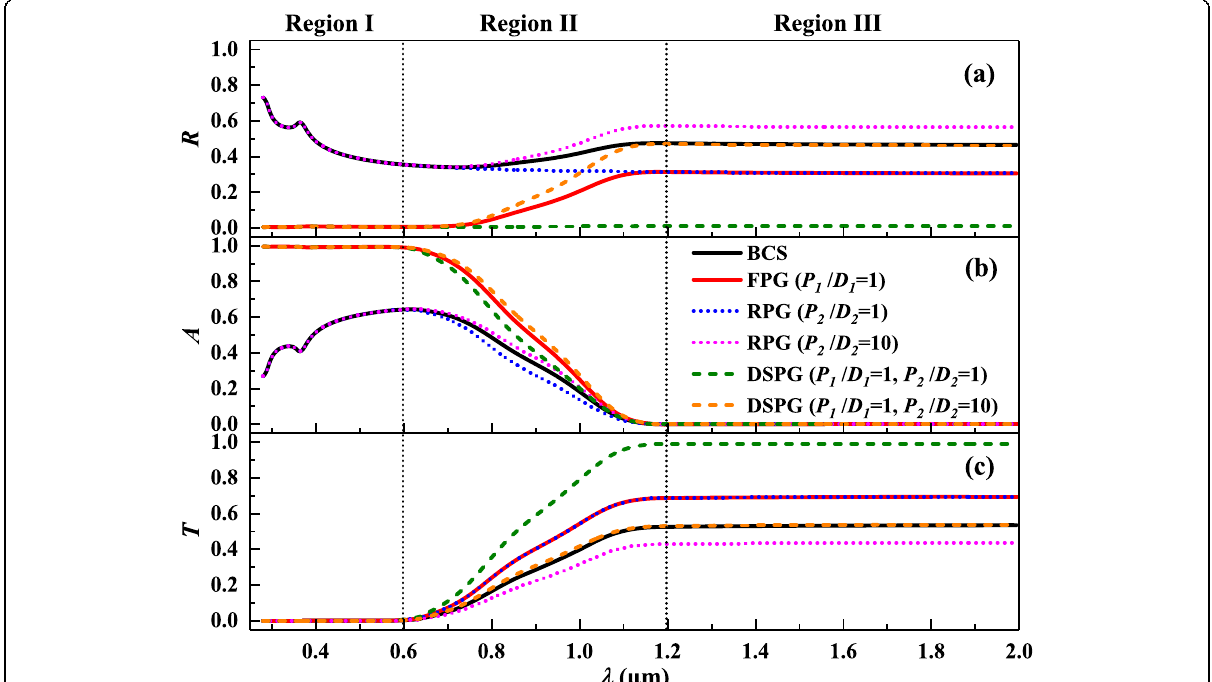
Fig. 3 Optical properties of different silicon pyramid grating structures under the given parameters compared to the BCS of the same thickness (BCS ( H = 10 μ m), FPG ( P 1 / D 1 = 1, H 1 = 200 nm), RPG ( P 2 / D 2 = 1 or P 2 / D 2 = 10, H 2 = 200 nm), DSPG ( P 1 / D 1 = 1, P 2 / D 2 = 1 or P 2 / D 2 = 10, H 1 = H 2 = 200 nm)). ( a ), ( b ), and ( c ) are the total light reflectivity, absorptivity, and transmissivity,